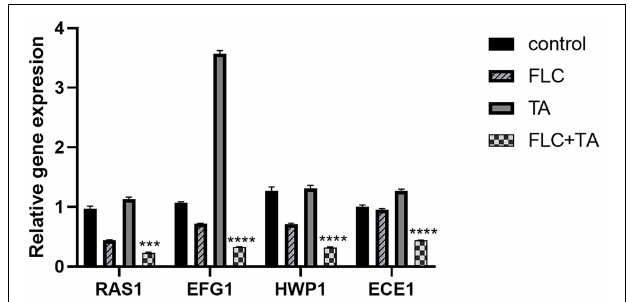
FIGURE 8 | The mRNA transcription levels of the Ras-cAMP-PKA pathway and hyphae-related genes. The mRNA transcripts were significantly down-regulated in the TA combined with the FLC group. ACT1 was used as an internal reference gene and quantified using the 2- (cid:49)(cid:49) CT method. *** p < 0.001, **** p < 0.0001.